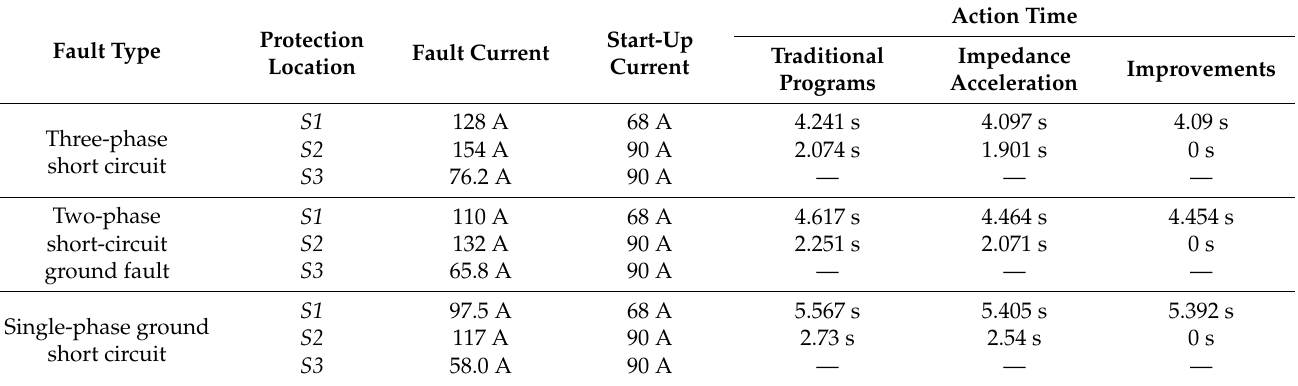
Table 8. Operating time of different protection schemes in the case of line BC via 100 Ω ground resistance fault.